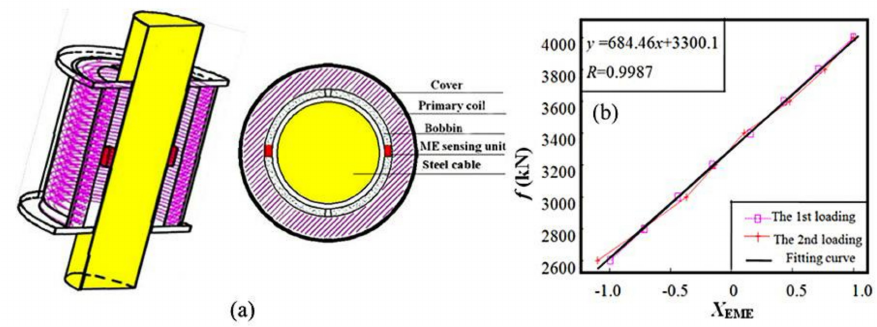
Figure 14. ( a )Structure of the EME sensor; ( b ) Stress response of EME sensors [85]. In 2020, Chen et al. fabricated a strain sensor based on ME heterostructures, the measurement setup of which was shown in Figure 15a [86]. The frequency shift of fer- romagnetic resonance occurred in NiCo film by applying an elastic strain generated by piezoelectric single crystal PMN-PT was employed to detect the substrate’s strain status. When excited at 9.4 GHz, the resonant field H r decreased from 956.65 Oe to 802.83 Oe with the strain ε increased from 0 µε to 700 µε , indicating a resonant frequency shift of about 430.7 MHz, as shown in Figure 15b. Accordingly, the calculated strain sensitivity S = ( ∆ f / f )/ ε was determined as 65.46 ppm/ µε [86]. Considering the resolution of FMR spectra, the limit of detection of the wireless strain sensor was around 0.54 µε , which was comparable with that of commercial metal-foil sensors that needed connection wires [86].